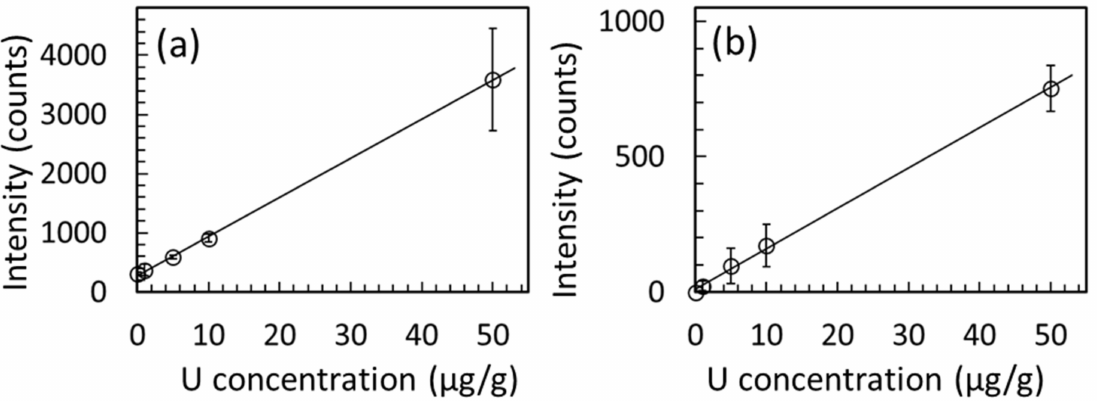
Figure 4. Calibration lines of 1–50 µ g/g U in mixed solutions of urine treated with five-fold HNO 3 . Horizontal axis, U concentration ( µ g/g); vertical axis, X-ray intensity of ( a ) U-L α (12.8–14.2 keV) and ( b ) U-L β 1 (16.8–17.8 keV) lines. Each point is mean and error of data from three positions per specimen. Note that count of U-L α (12.8–14.2 keV) line overlaps with counts at Br-K β line.